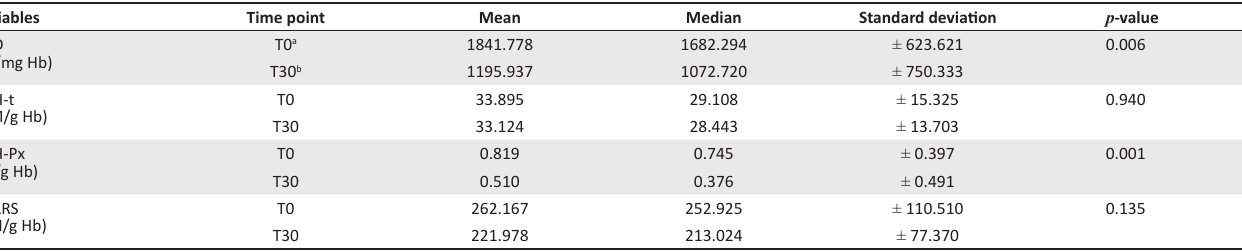
TABLE 1: Superoxide dismutase, total glutathione, peroxidase glutathione and thiobarbituric acid reactive substances values in sheep red cells prior to and 30 min after lung biopsy.